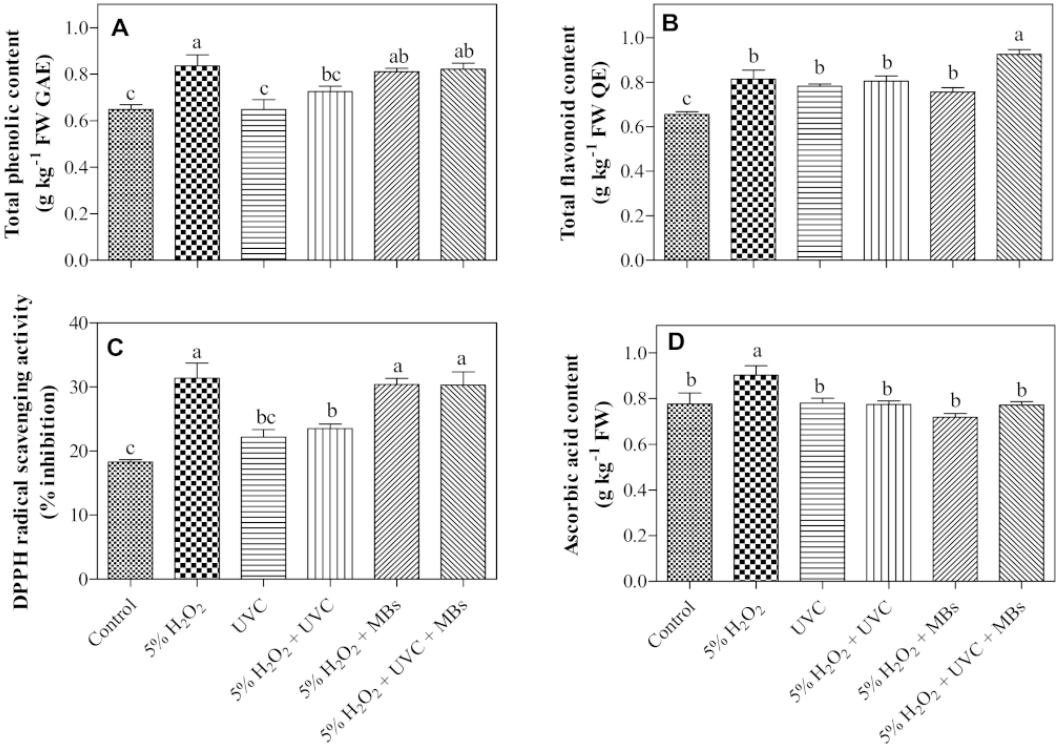
Figure 4. Effects on seed decontamination treatments on ( A ) total phenolic content, ( B ) total flavonoid content, ( C ) DPPH radical scavenging activity, and ( D ) ascorbic acid content of their corresponding roselle microgreens. Data are means of four replications ± SE. Means with the same letter are not significantly different at p ≤ 0.05 by the DMRT